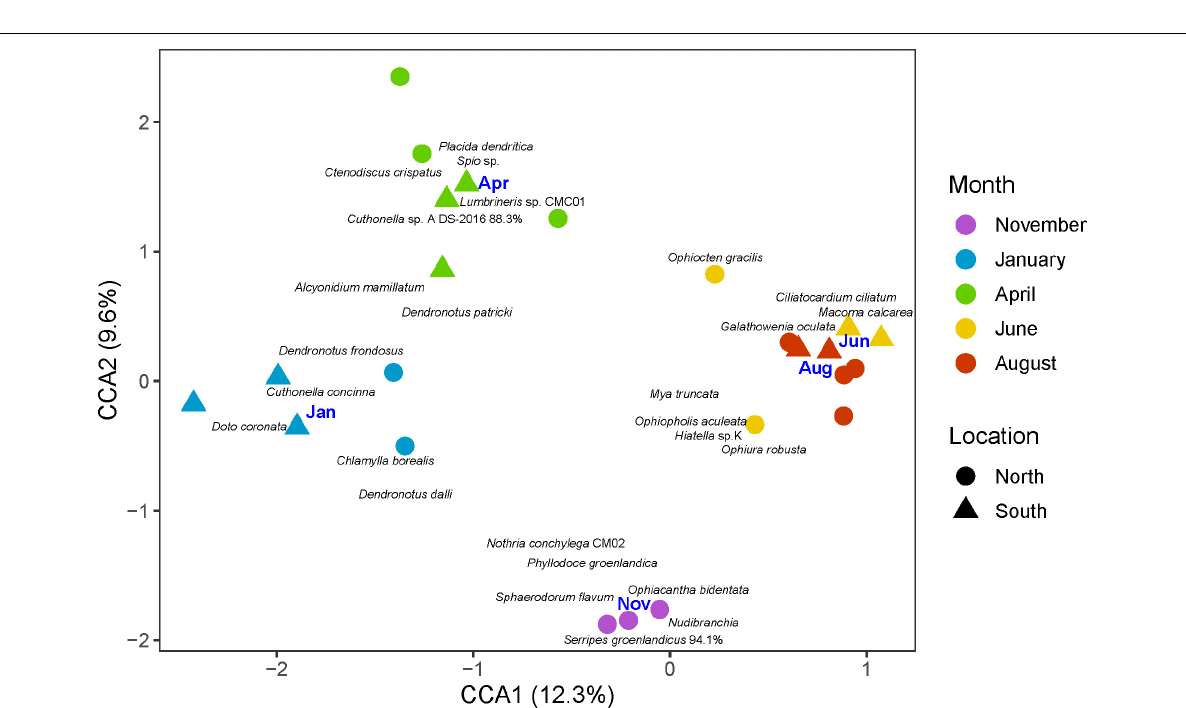
Frontiers in Marine Science |